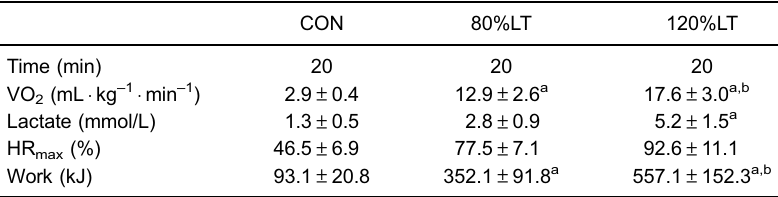
Table 1. Mean values for VO 2 , blood lactate, % maximal HR and total work during the exercise (80%LT and 120%LT) and control conditions. CON 80%LT